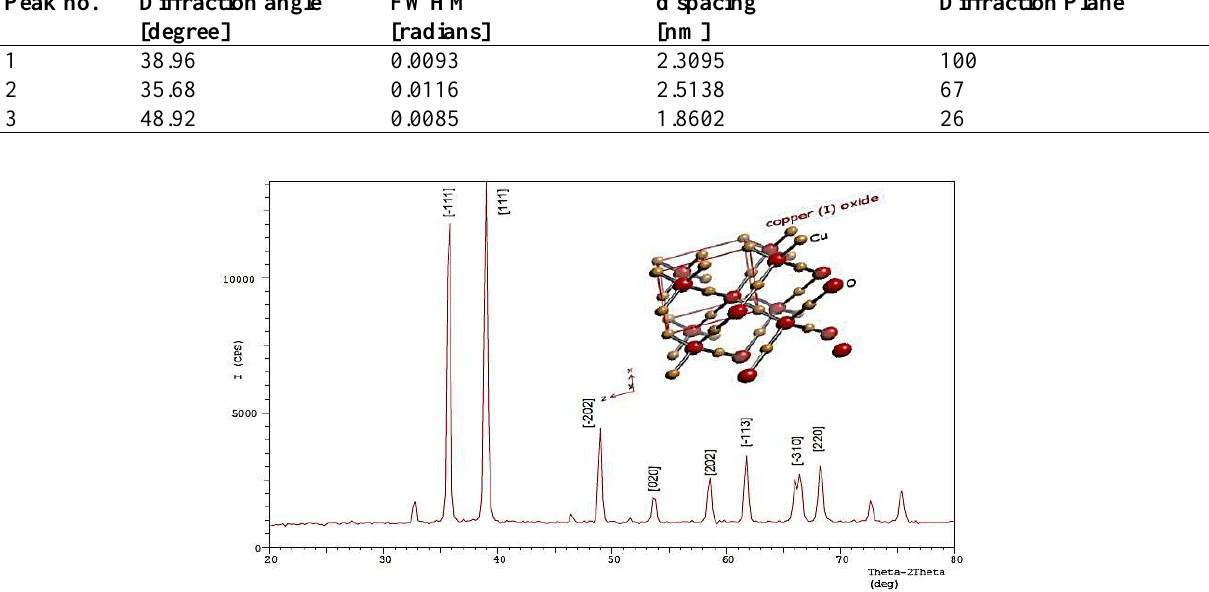
Fig. 1. XRD pattern of prepared CuO nanoparticles.